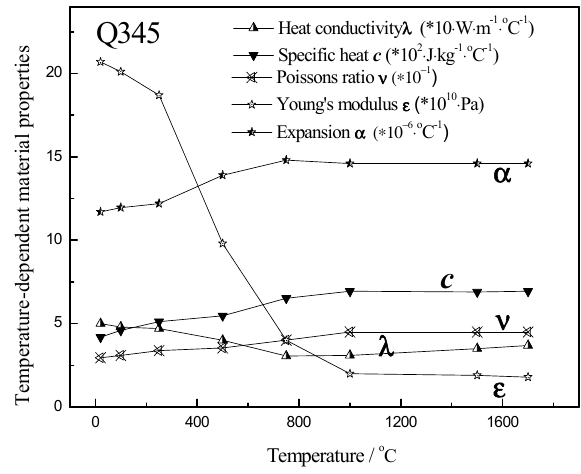
Figure 10. Temperature-dependent material properties of Q345 steel.